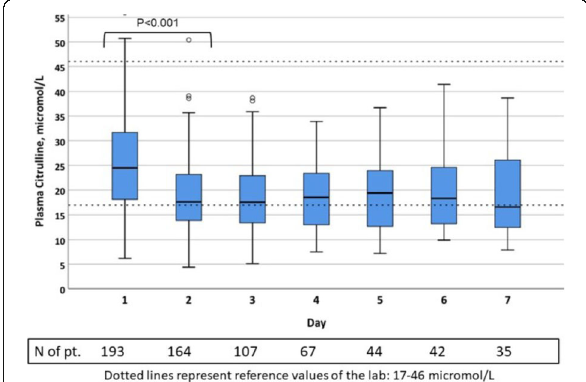
Fig. 1 (abstract 000298). Plasma citrulline dynamics in all patients